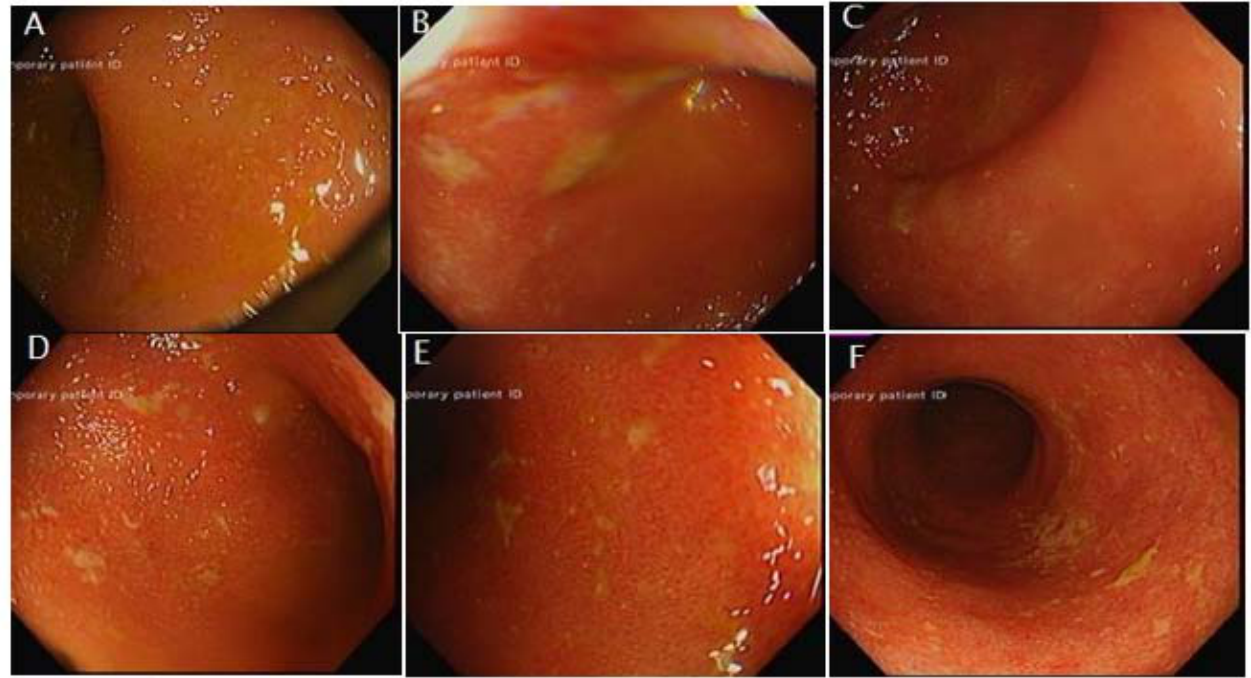
Figure 2. From mid-descending colon to rectum ( A – F ): There was a continuous superficial inflammation. Loss of vascular pattern occurred throughout. Aphthous ulcers were seen but only superficially. Infective causes were ruled out with the stool tested negative for invasive bacterial and viral pathogens. Although the patient was not considered to be severely immunocom- promised, a biopsy taken from the colon was still tested for